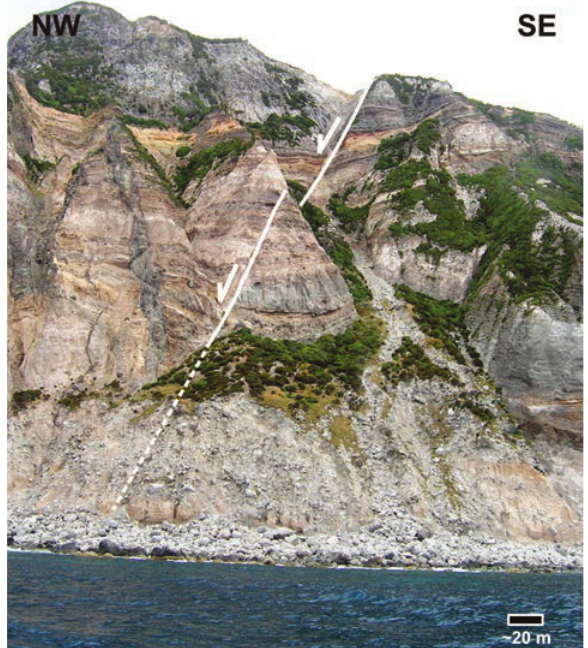
Figure 9. Example of a fault trace exposed in a sea cliff south of Serra Branca. Legend as in Figure